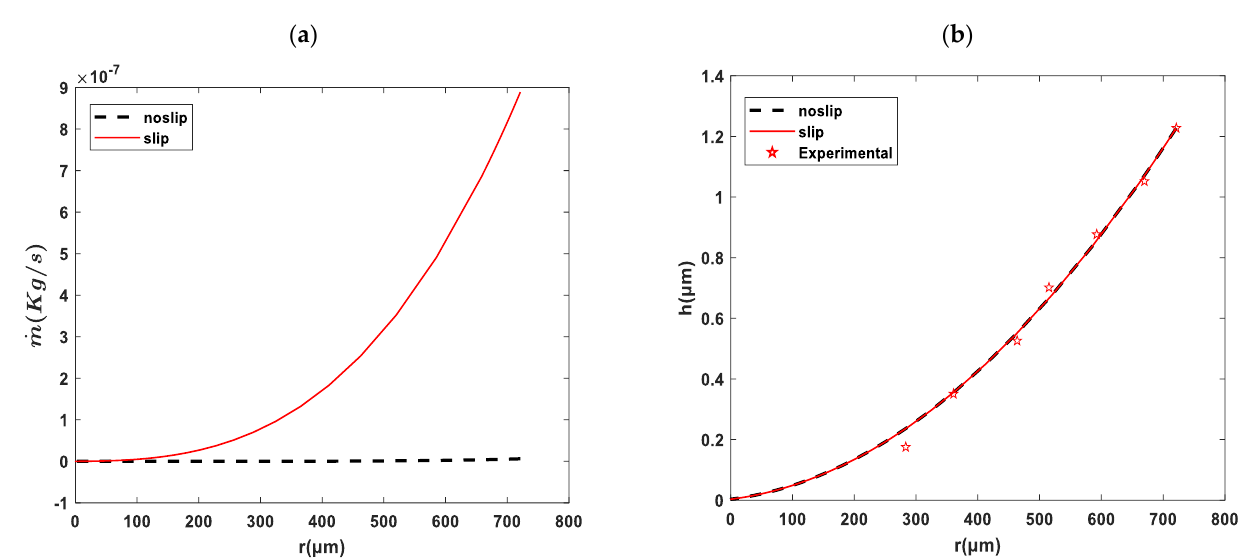
Figure 8. Radius evolutions of ( a ) evaporative mass flux; and ( b ) film thickness for no slip and slip conditions at a time step of 3.9 ms. conditions at a time step of 3.9